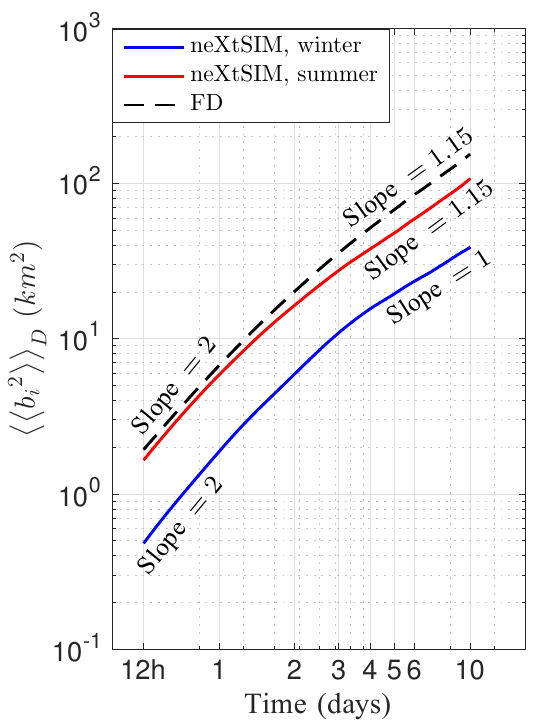
Figure 13. Spatial domain average of the variance of the distances b i as a function of time from t = 12h to t = 10 days, for the neXtSIM (solid) and FD (dashed) models and for winter (blue) and summer (red). As the results for winter and summer are identical in FD, only one curve is plotted (black dashed line). The Brown- ian regime (slope = 1) is reached by neXtSIM during the winter, while in the other cases a super-diffusive regime is obtained (slope = 1 .